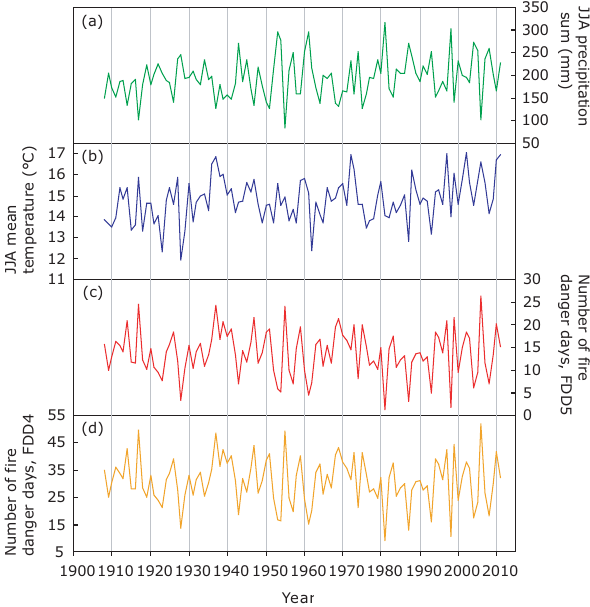
Fig. 7. June–August (a) precipitation sum, (b) mean temperature, and the average number of the estimated fire danger days for (c) FDD4 and (d) FDD5 in the southern study area (regions 1–15 and 20) in